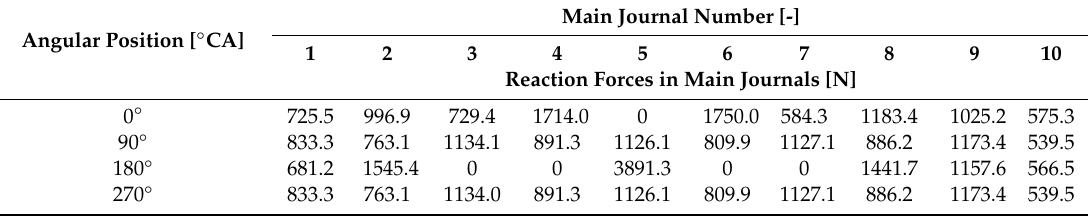
Table 3. Changes in the reaction forces where the supports contact each main journal when the shaft rotation angle changes by 90 ◦ and when one of the axis main journals (journal no. 5 counting from the timing gear end) is o ff set upwards by 0.03 mm relative to the others.